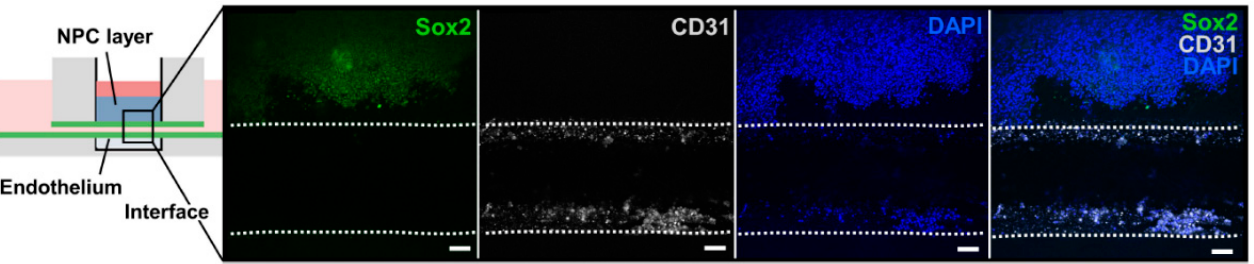
Figure 3. Bioprinted tissue-on-chip with vascular-like channel. Confocal images of hiPSC-NPCs encapsulated within ELP-RGD bioprinted on top of a channel seeded with HUVECs and cultured for 5 days. Scale bars represent 50 mm. Reprinted with permission granted under CC-BY license (https://creativecommons.org/about/cclicenses/ (accessed on 30 October 2022)), published